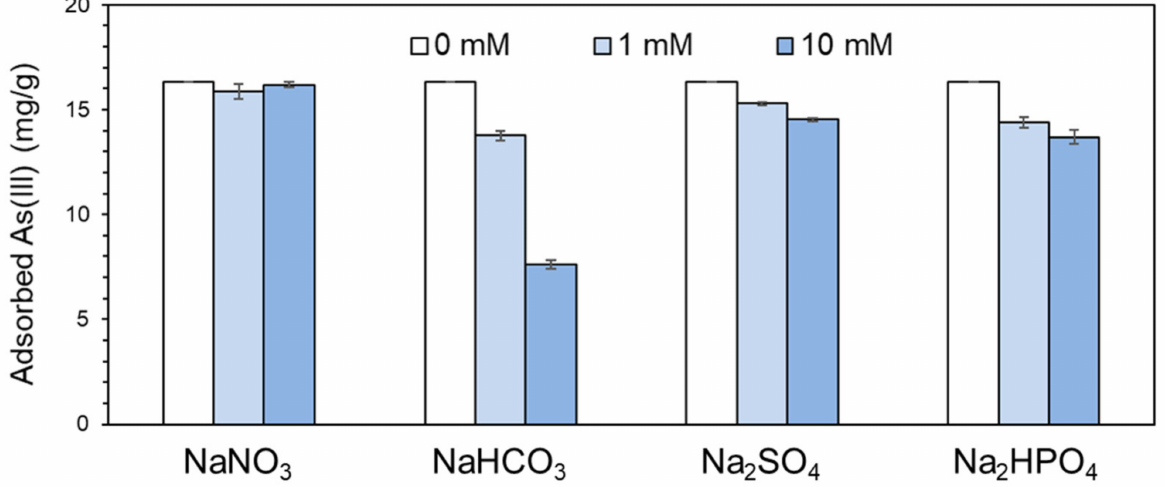
Figure 6. The effect of different concentrations of co-existing anions on As(III) adsorption onto Al-FWB at a 100 mg/L initial As(III)